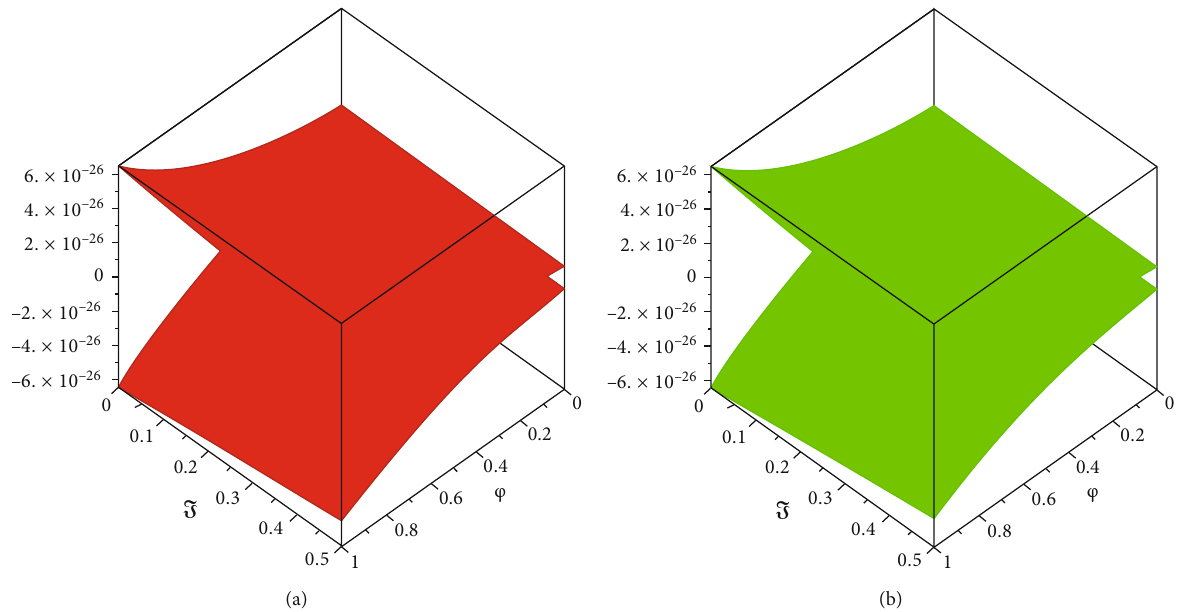
Figure 5: (a) The three-dimensional fuzzy lower and upper branch graph of approximate series result at ϱ = 1 and (b) at fractional-order of ϱ = 0 : 8 .